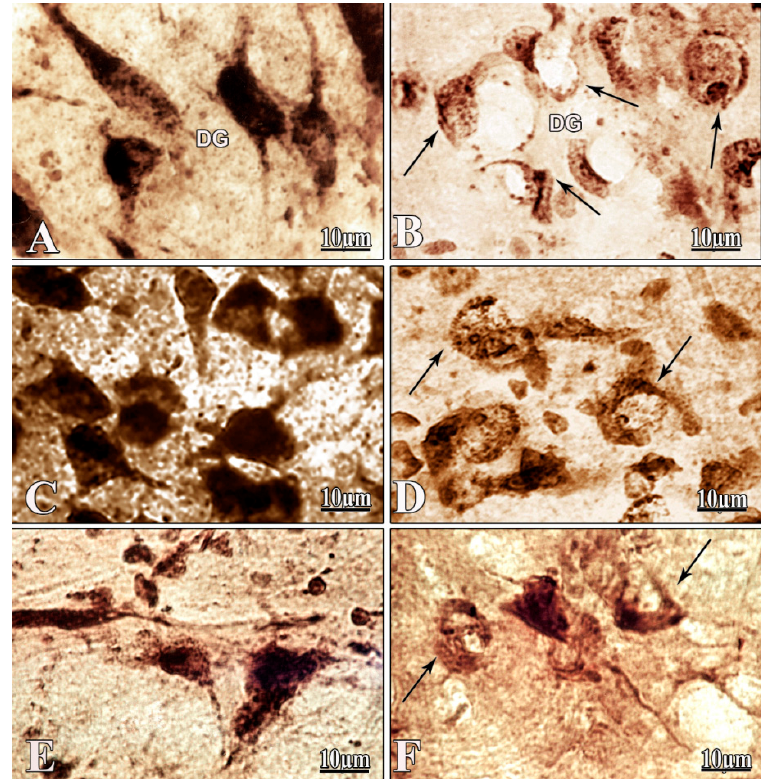
Figure 4. Images of morphologically examined neurons of hippocampus, amygdala, and nucleus basalis magnocellularis (NBM) in the control and amyloid groups. Frontal slices of hippocampal ( A ), amygdala ( C ), and NBM ( E ) neurons of the control rat brain. Degenerated, swollen neurons with eccentrically disposed nuclei (indicated by black arrows) of the hippocampus ( B ), amygdala ( D ), and NBM ( F ) after bilateral intracerebroventricular (i.c.v.) injection of A β 25–35. DG—dentate gyrus of the hippocampus. Magnification: ×1000 ( A – F ).